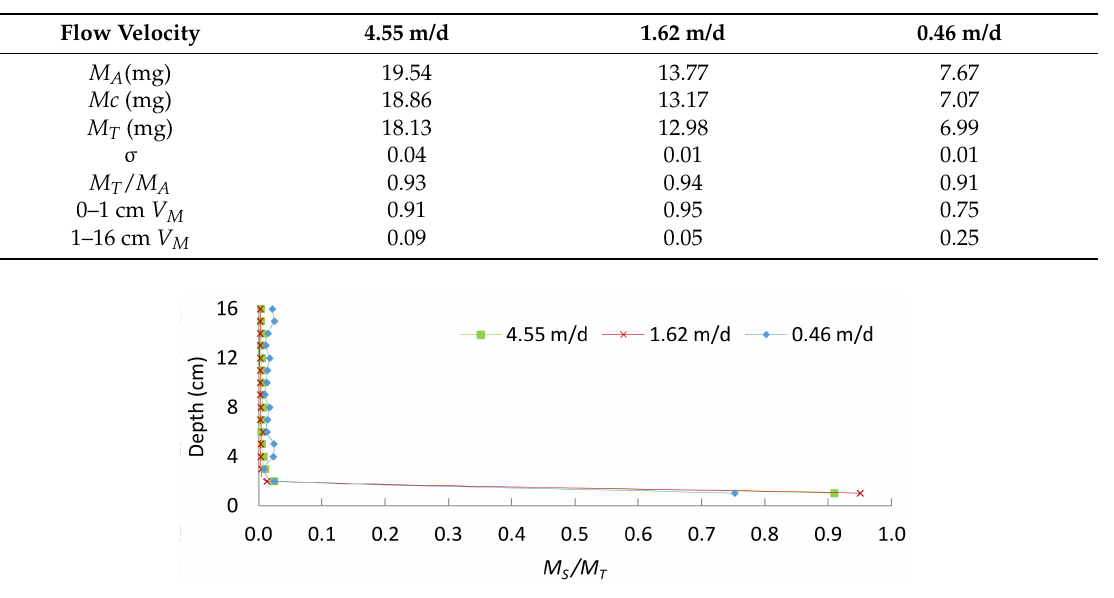
Table 1. Mass ratios in the column.